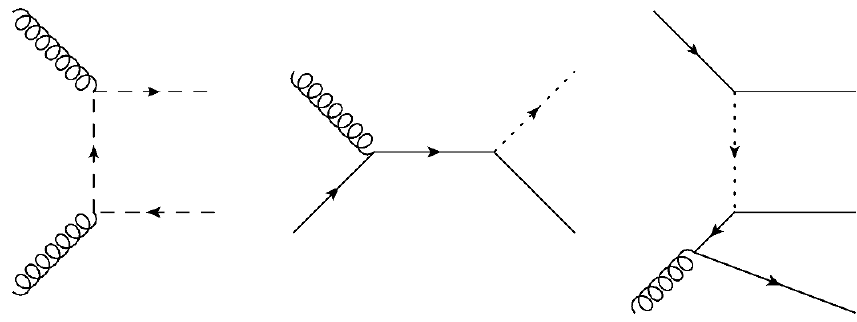
Figure 7 . Representative Feynman diagrams for (left to right): mediator pair production, associ- ated production, and (cid:31)(cid:31) + jet production at the LHC.